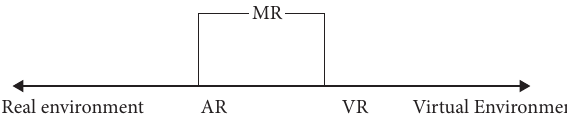
Figure 1: Differences and connections among the three technol- ogies of VR, AR, and